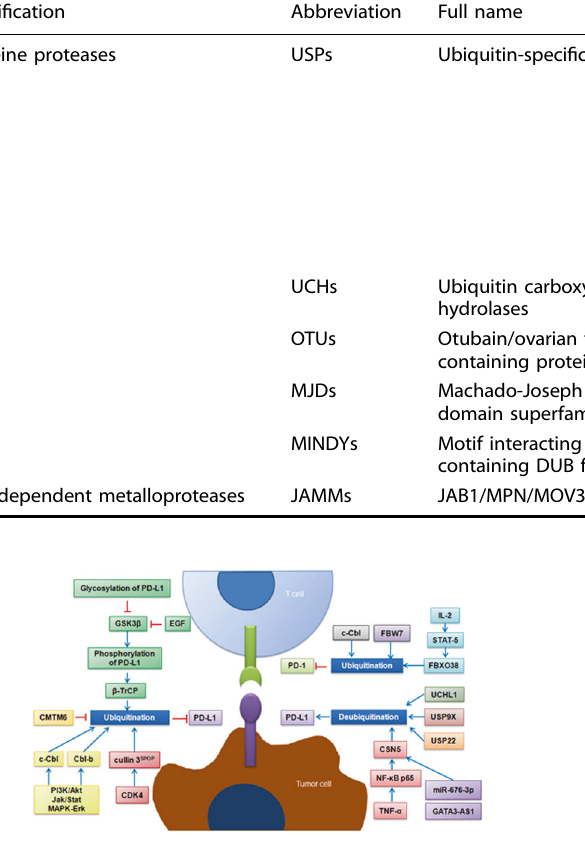
Fig. 2 Schematic diagram of the regulation of PD-1/PD-L1 pathway by modulating